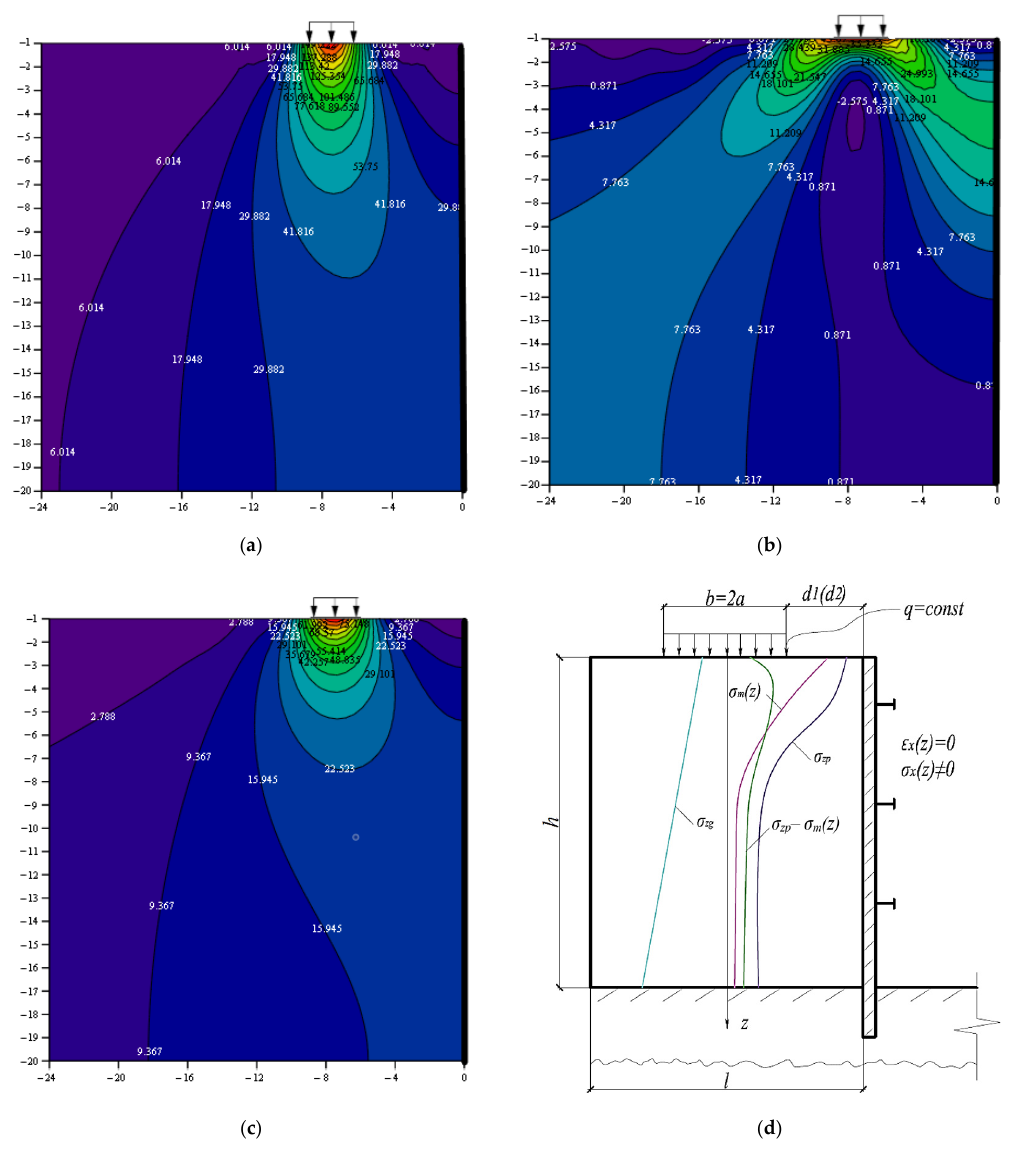
Figure 3. Stress isopoles at q = 100 kPa, d 1 = 6 m, and b = 2 a = 3 m: ( a ) vertical stress σ y ; ( b ) horizontal stress σ x ; ( c ) mean stresses σ m ; ( d ) design scheme for determination of the shear and volumetric strains of a weighty soil of limited thickness resting upon an incompressible soil base based on Hencky’s physical equations.